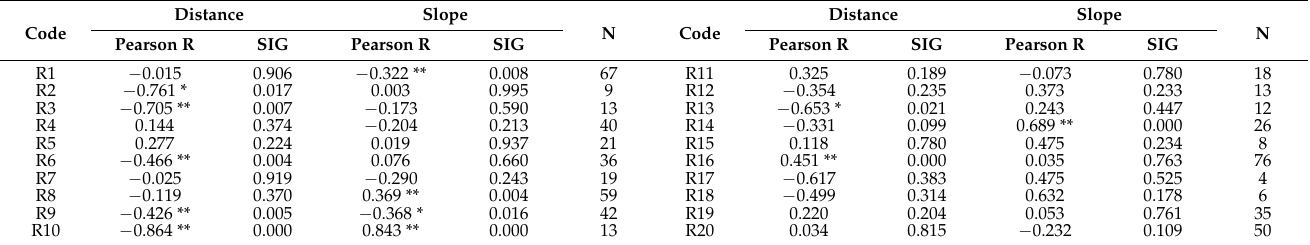
Table 5. The correlation coefficients between model deviation along road and influential